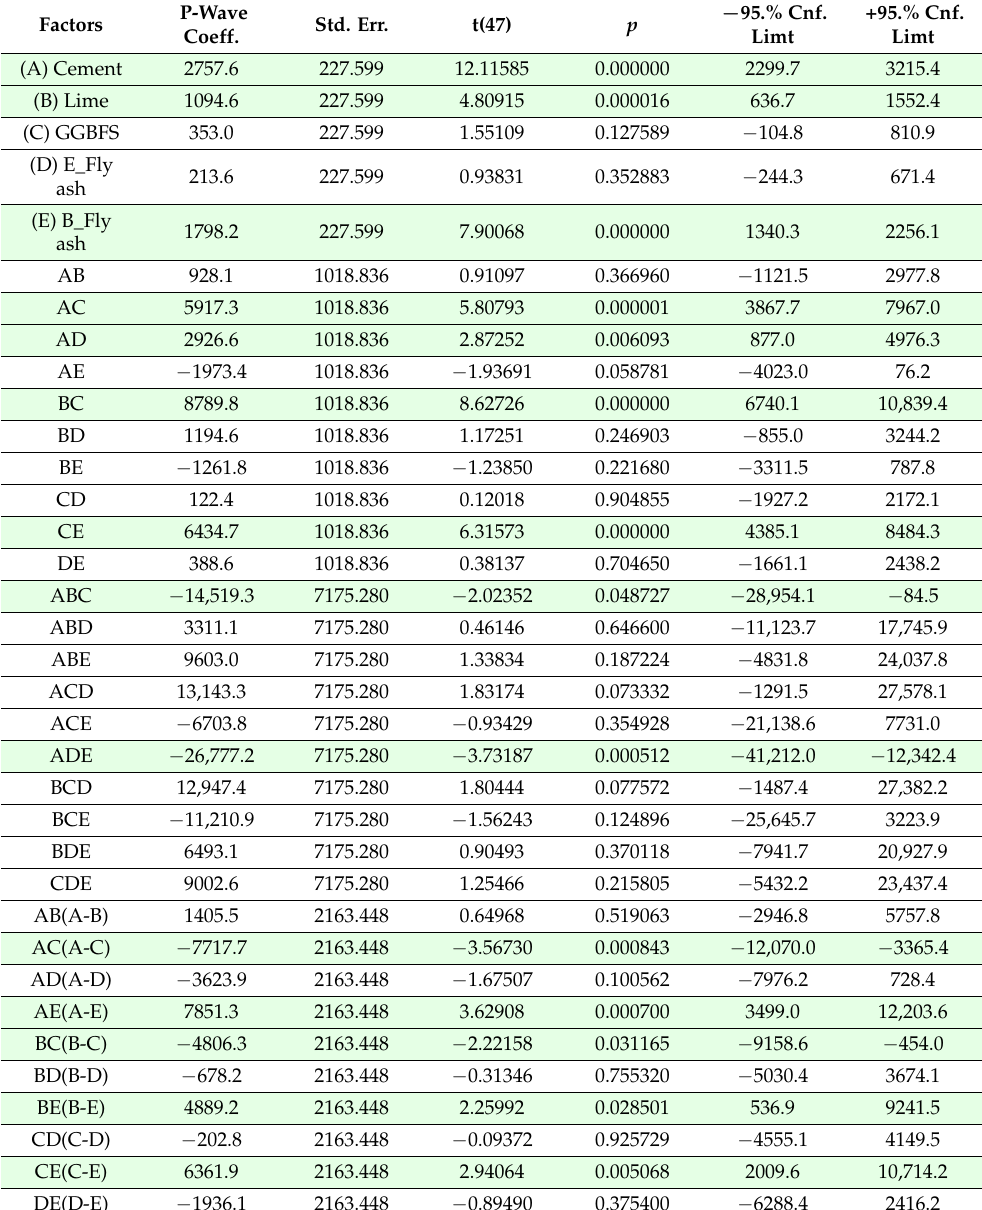
Table 5. The effects from various binders on soil stabilisation on day 28th of curing, measured by P-wave